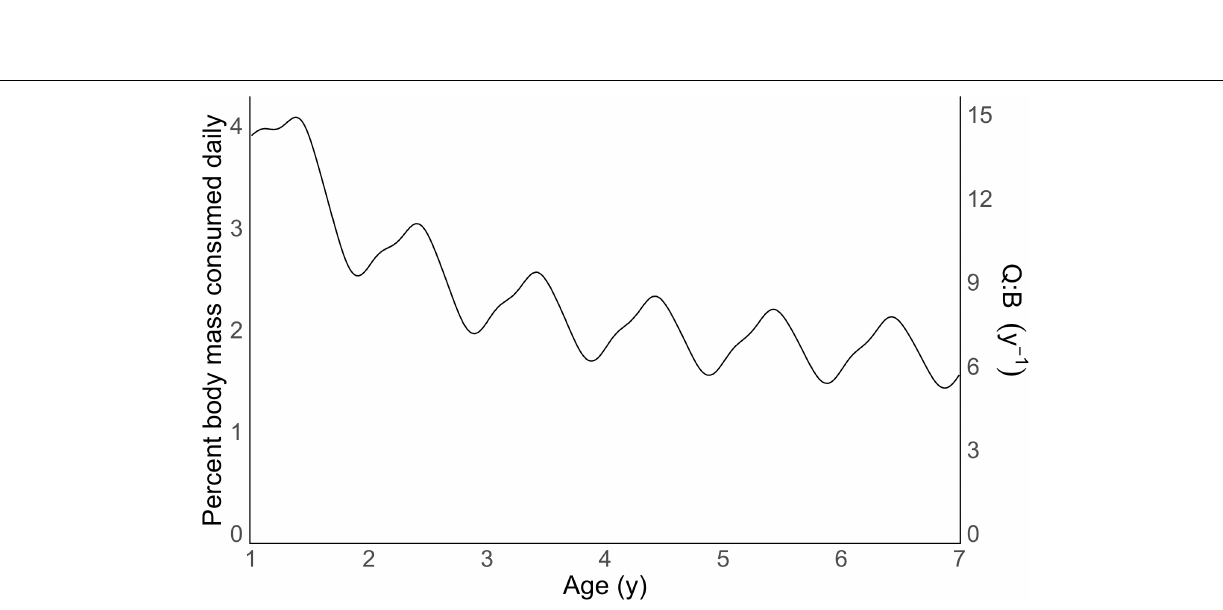
FIGURE 3 | Body mass consumed daily (%) and consumption: biomass ratios (Q: B) of Yellowfin Bream based on the bioenergetic model and prey composition presented here. x -axis truncated to start at year 1 for